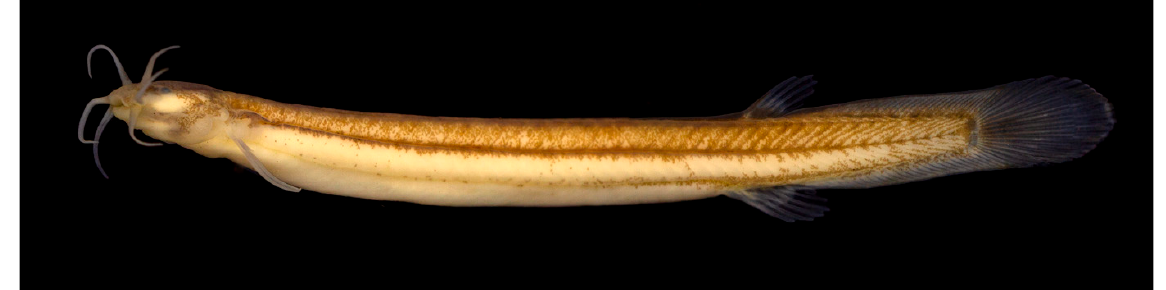
Figure 8. Listrura macacuensis sp. nov., UFRJ 12669, holotype, 29.8 mm SL. Table 2. Morphometric data of Listrura macacuensis sp.